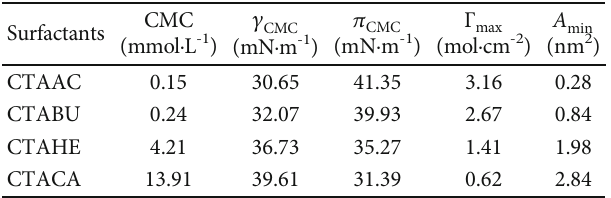
Table 3: Surface properties of di ff erent surfactants at room